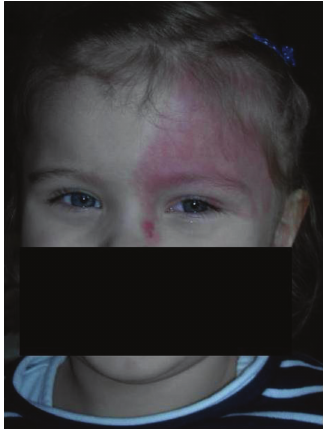
Figure 1: Di ff use nevus flammeus involving the left upper eyelid and forehead associated with Sturge-Weber syndrome.